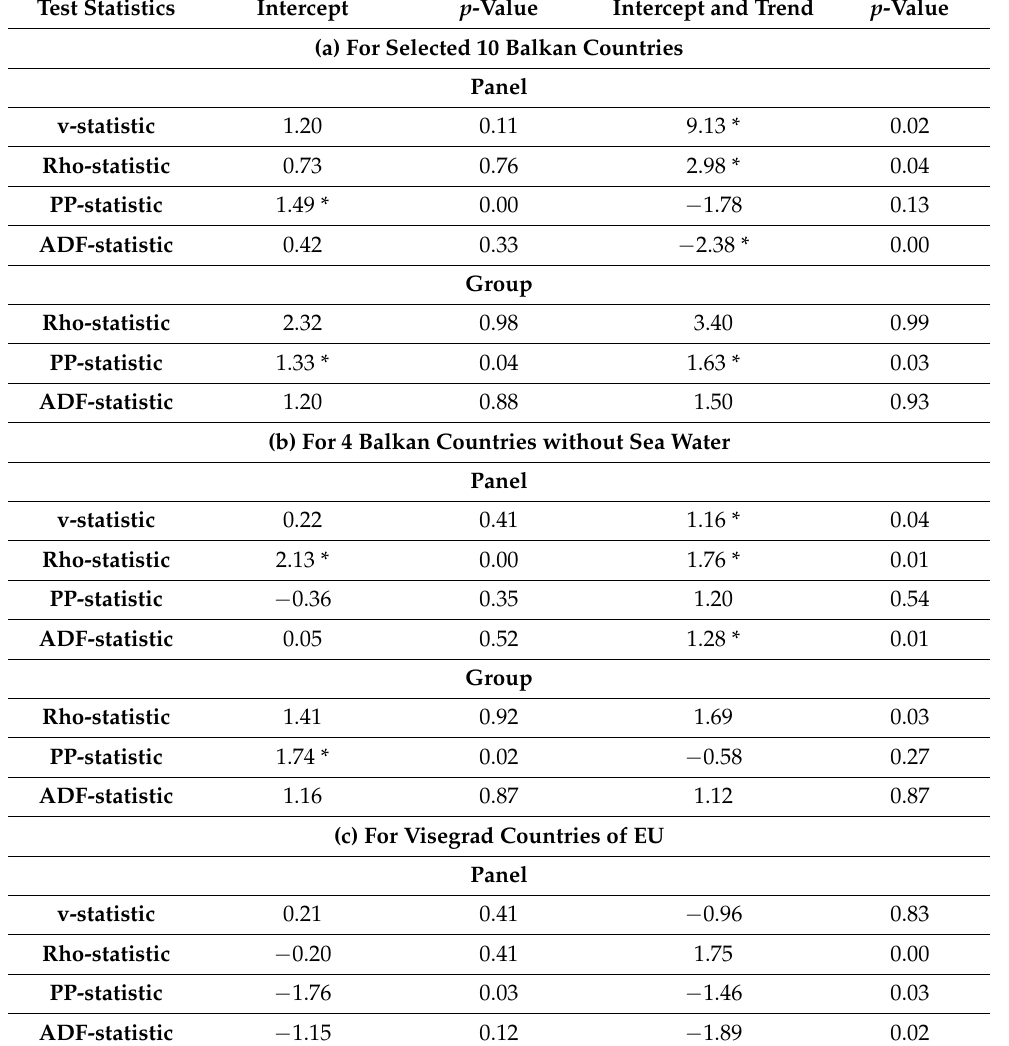
Table 6. The results of Pedroni Cointegration